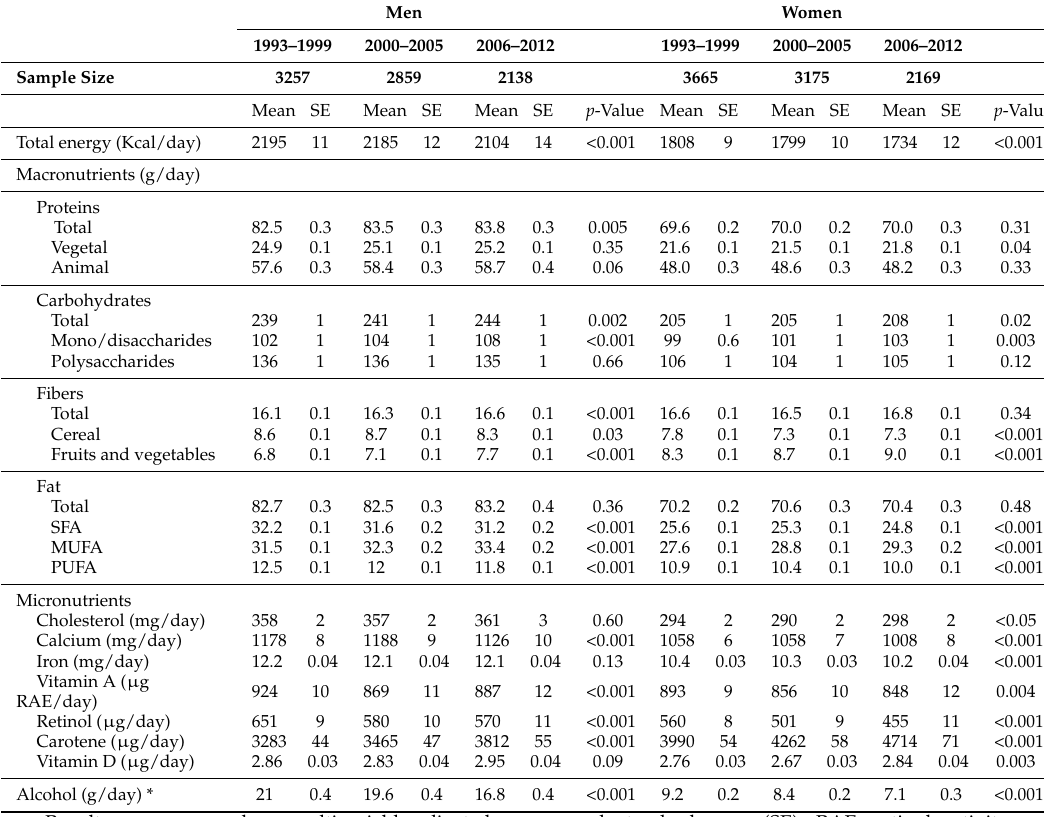
Table 2. Total energy and nutrient intakes of the participants of the “Bus Santé” study, Geneva, Switzerland, according to study period, stratified by